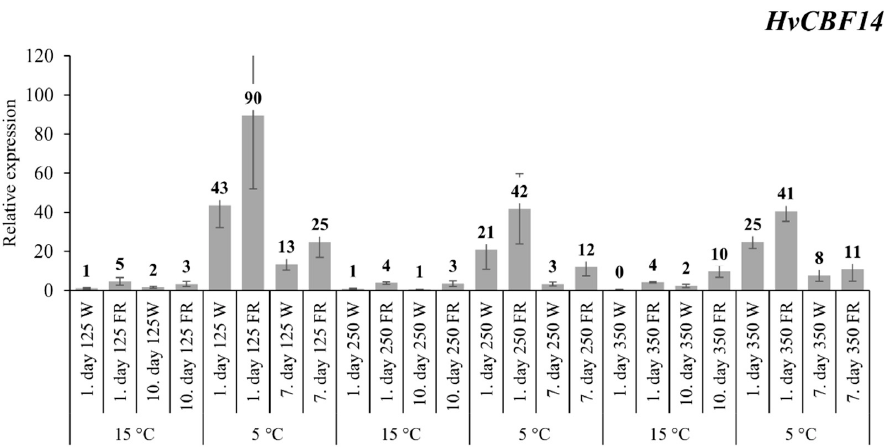
Figure 1. The expression pattern of the HvCBF14 gene with white light and low R:FR illumination. The examined plantlets were grown under 12 h photoperiod where the samples were collected six to eight hours after the illumination began. The X -axis shows the phases of the treatments; Transcript levels were calculated with the ΔΔ Ct method. The data and error bars, which represent the standard deviation, originated from three biological replicates with three technical samples.